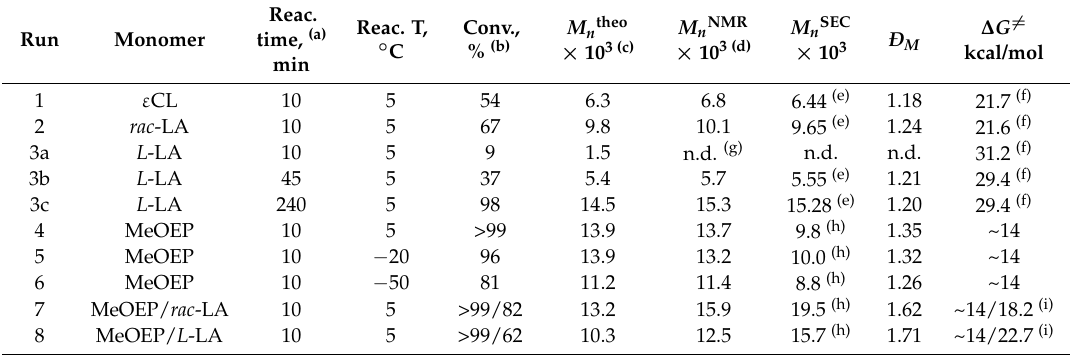
Table 3. Polymerization experimental data and calculated ∆ G (cid:54) = values for Mg1 -catalyzed ROP of cyclic esters and MeOEP. Reaction conditions: 1 M solution of monomer in CH 2 Cl 2 , 1 mol % of Mg1